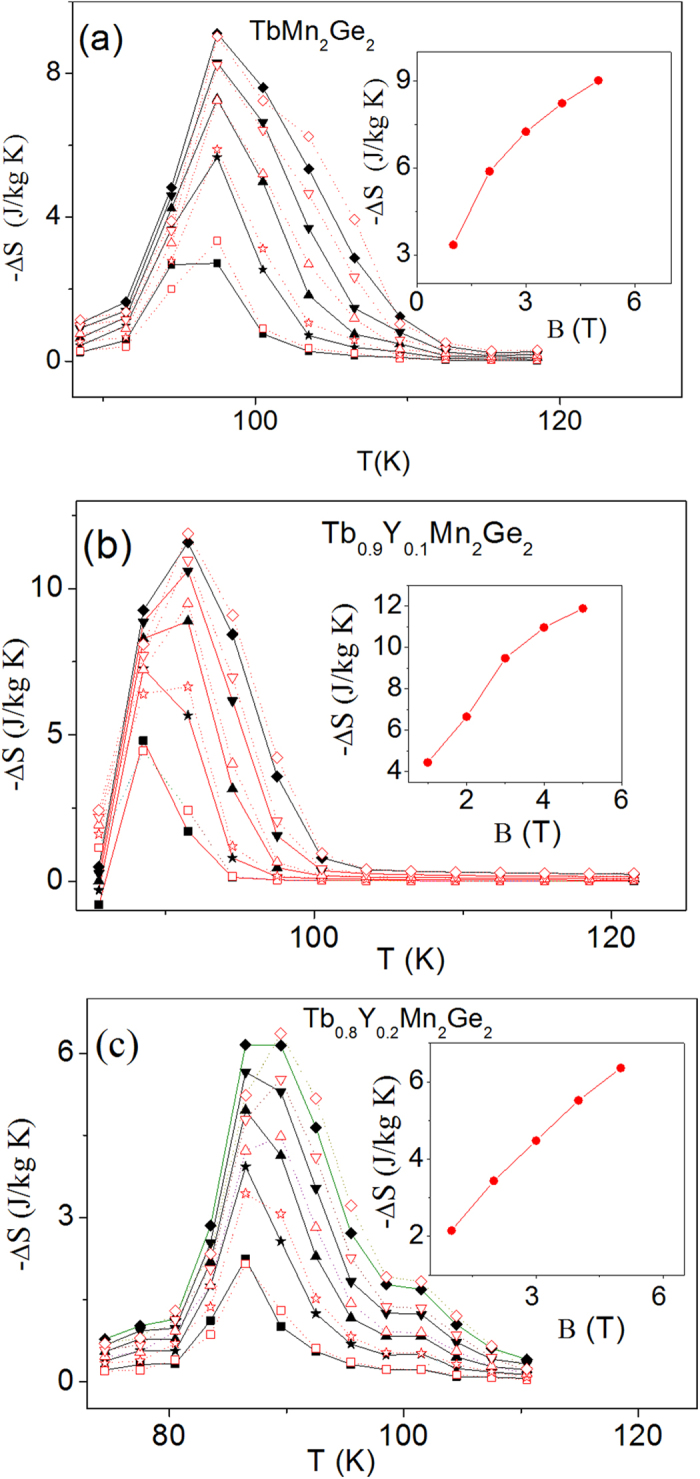
The magnetic entropy changes around the ferromagnetic transition temperatures for applied magnetic fields from 1–5T.(a) TbMn2Ge2, (b) Tb0.9Y0.1Mn2Ge2 and (c) Tb0.8Y0.2Mn2Ge2 (black full symbols ◾ ★ ▴ ▾ ♦ for 1–5 T respectively during increasing field and the red empty symbols correspond to 1–5 T for the decreasing field). The insets show the variation of the maximum values of magnetic entropy changes for the decreasing field values.